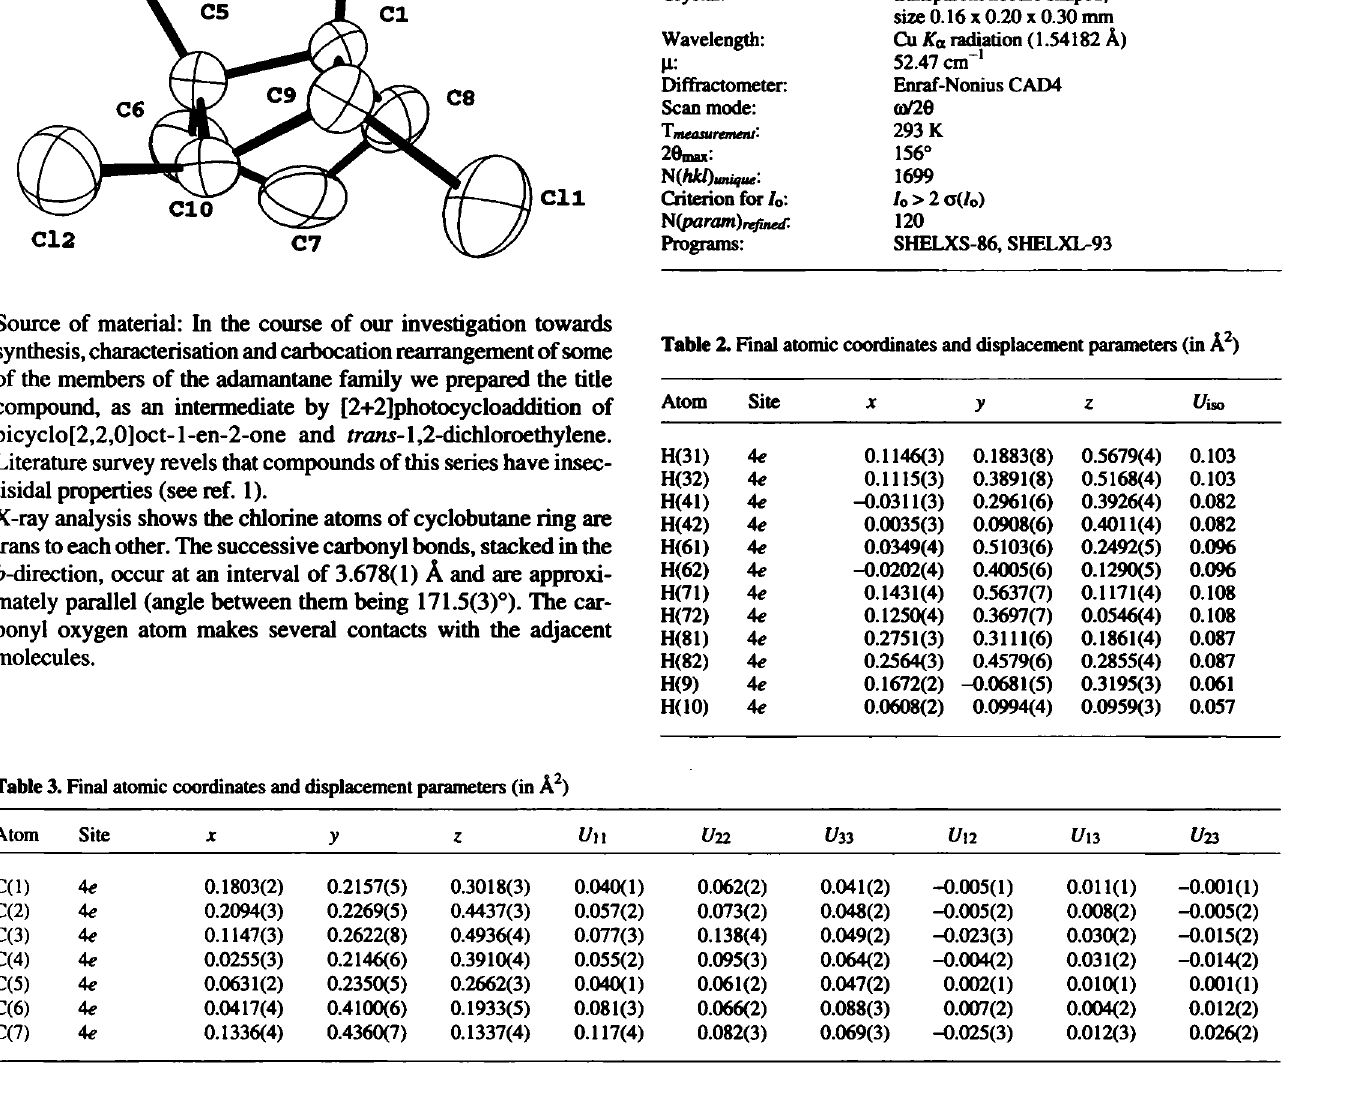
26inu: Ν (hkbumque·.